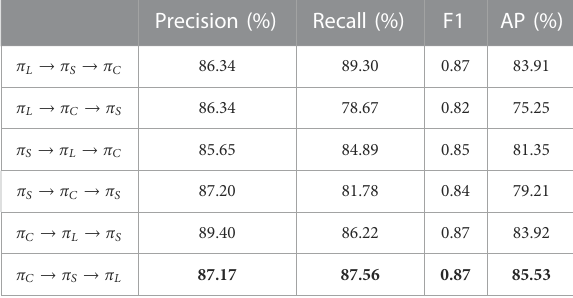
TABLE 2 Performance of the model with different concatenation